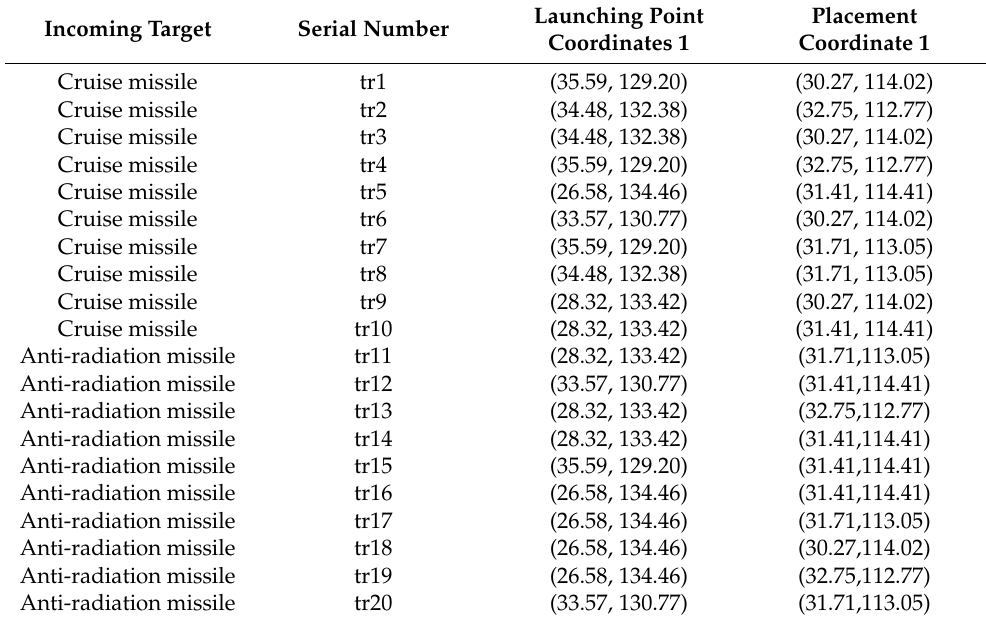
Table 5. Incoming target parameters.